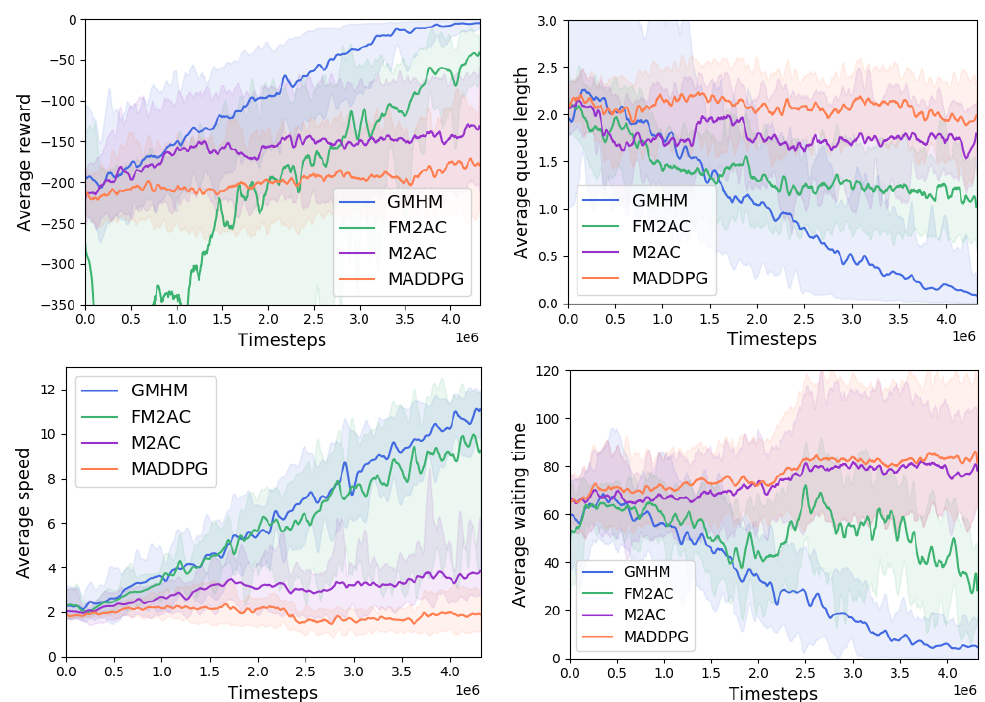
Figure 5. Experiment results in Monaco traffic network. The top two figures are the results of our method applied to A3C. The bottom two figures are the experiment results based on PPO.